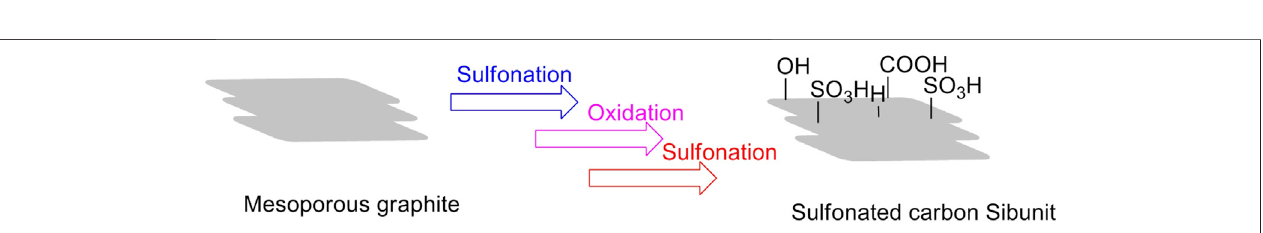
FIGURE 7 | Sulfonated carbon Sibunit synthesized by using mesoporous